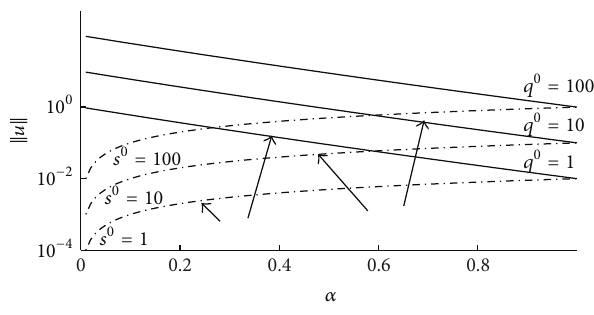
Figure 1: The dependencies for norm of control from 𝛼 at 𝑝 󸀠 = 1 (logarithmic scale used for ordinates).